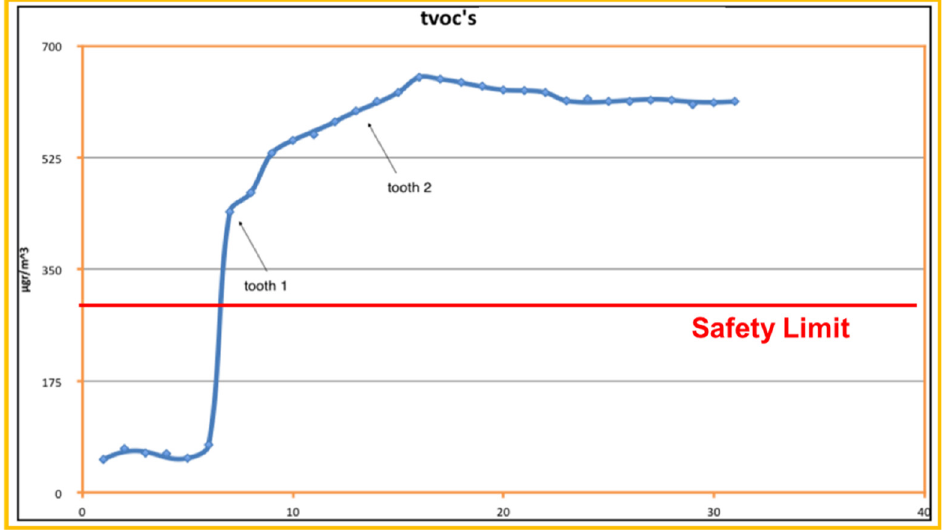
Figure 1. Detailed presentation of TVOC’s recordings (over a 40 min span), on D2 for the period of Er:YAG Laser usage, 10:35 to 10:55. The arrows indicate the completion of working time for each tooth.